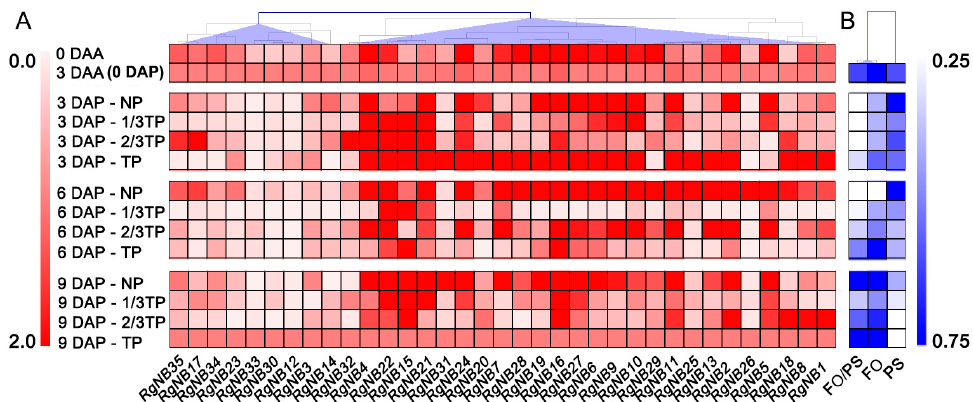
Figure 5. The heatmaps of the 35 NB-LRR expressions in R. glutinosa roots and the numbers of FO and PS and their ratios in R. glutinosa rhizosphere soils. ( A ) The expression profiles of 35 NB-LRRs in R. glutinosa roots over time. 3 DAA (0 DAP) is the control; ( B ) the changes in relative values of FO, PS and FO / PS over time. Calculation of the relative values: The cell numbers and the FO / PS values are first compared with that at 0 DAP (3 DAA), and then normalized ( Z -score) for each microorganism respectively to display in the same color scale. DAA: Days after acclimatization. DAP: Days after planting. NP: Soil that was never planted with R. glutinosa for at least 10 years. TP: Soil that was consecutively planted with R. glutinosa in the same soils for three